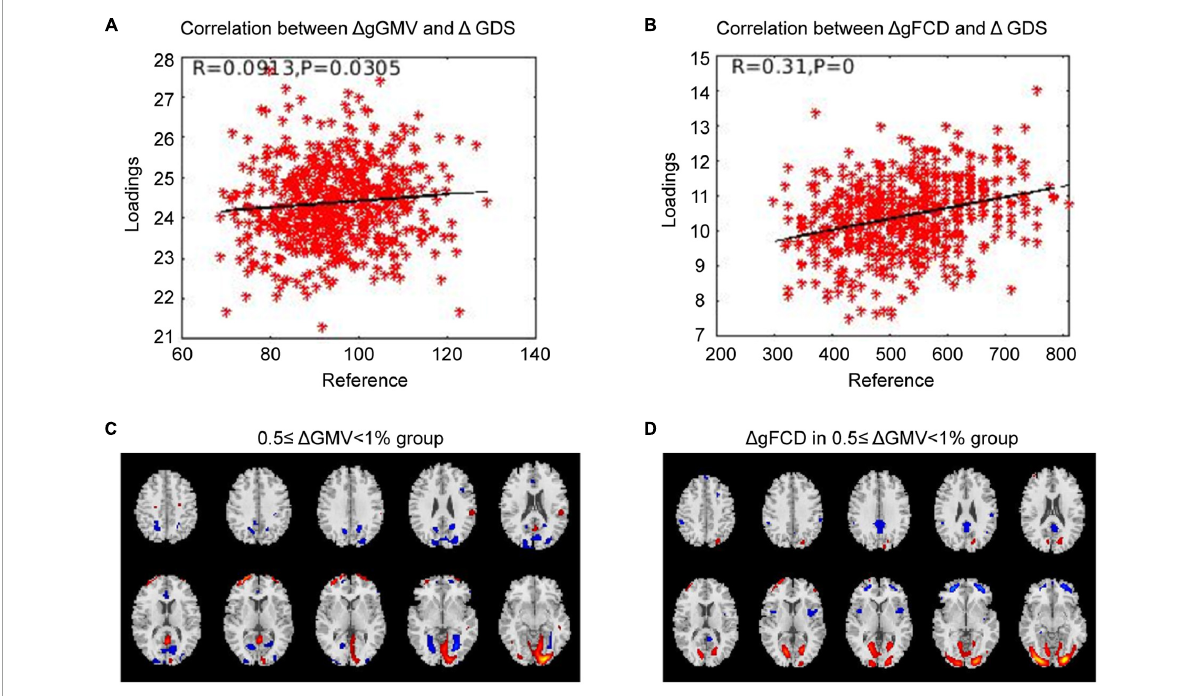
FIGURE1 The correlation between (cid:49) GMV/ (cid:49) gFCD and the cognitive deterioration in the mild whole-brain alteration group. Correlation analysis was performed to determine the relationship between subsequent cognitive decline after two years of treatment and baseline (cid:49) gGMV/ (cid:49) gFCD in the drug-naïve first-episode schizophrenia with 0.5 ≤ (cid:49) gGMV < 1% at baseline in the mild whole-brain alteration group. (A) Relationship between (cid:49) gGMV and (cid:49) GDS; (B) Relationship between (cid:49) gFCD and (cid:49) GDS; (C) The mild whole-brain alteration group with 0.5 ≤ (cid:49) gGMV < 1% at baseline; (D) (cid:49) gFCD in the mild whole-brain alteration